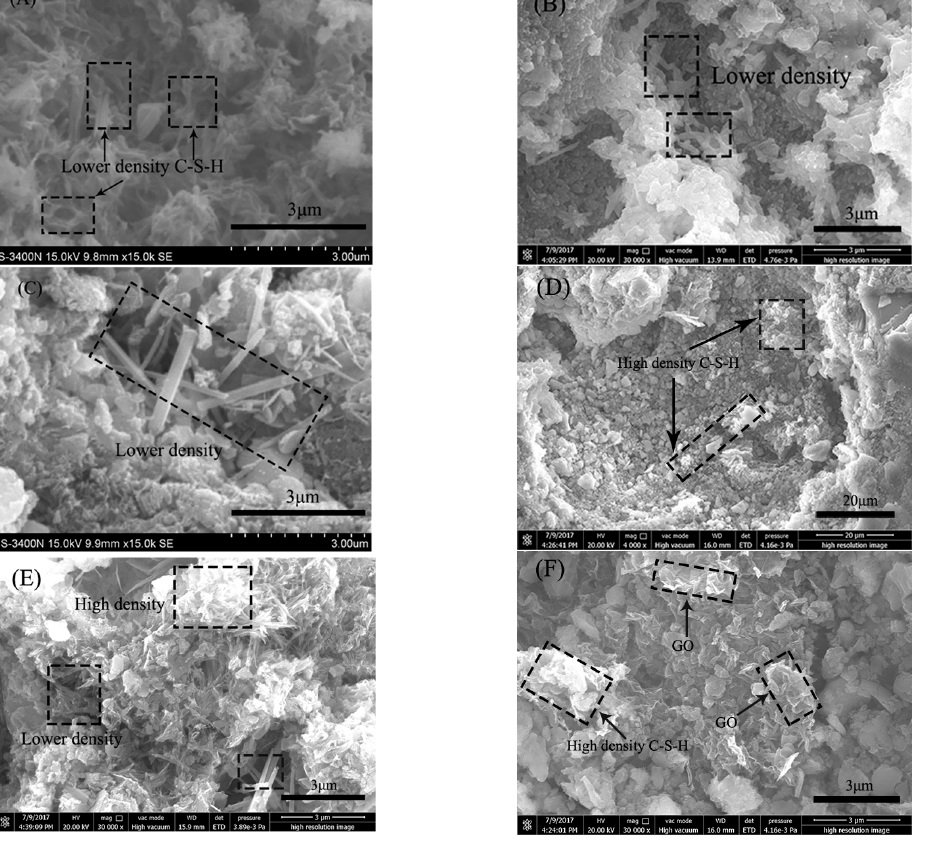
Figure 14. SEM images of crystal morphology at different magnifications in plain-RFA mortar sample ( A – C ) and in GO-RFA mortar sample ( D – F ) after 7 days curing.